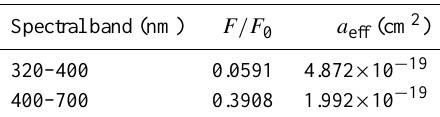
Fig. 1. Thick line: spectral optical thickness, τ (left scale) for 0.5DU of NO 2 . Thin line: corresponding approximate absorption, A , of solar irradiance by NO 2 (right scale). Table 1. Fractional solar flux ( F/F 0 ) and effective NO 2 absorption coefficients ( a eff